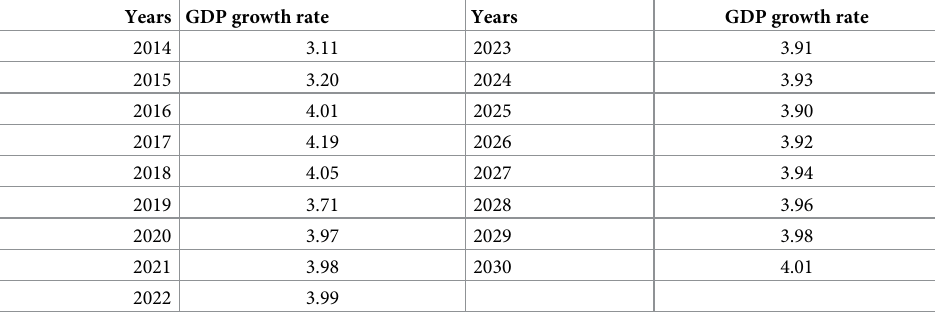
Table 13. The projected income growth